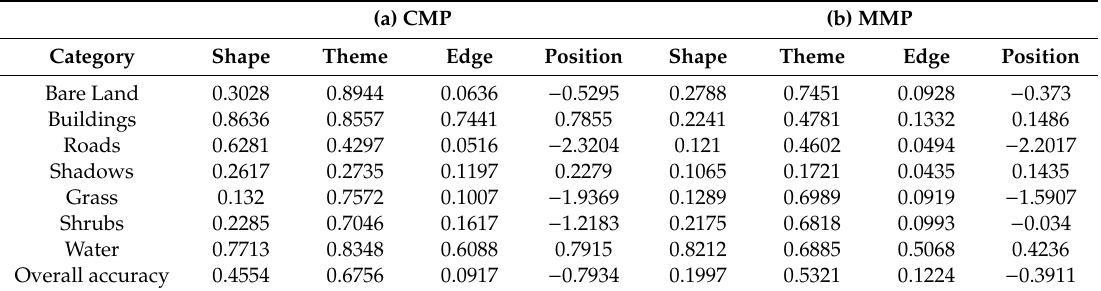
Table 4. Overall thematic and geometric accuracy results of (a) CMP and (b) MMP over Boksburg.